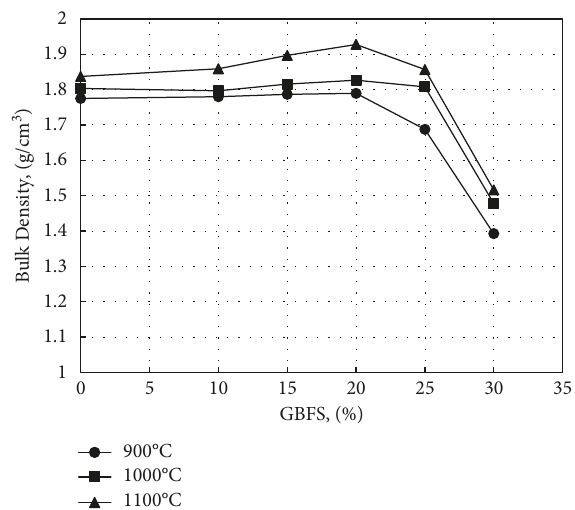
Figure 6: Variation of bulk density with different GBFS percentage.